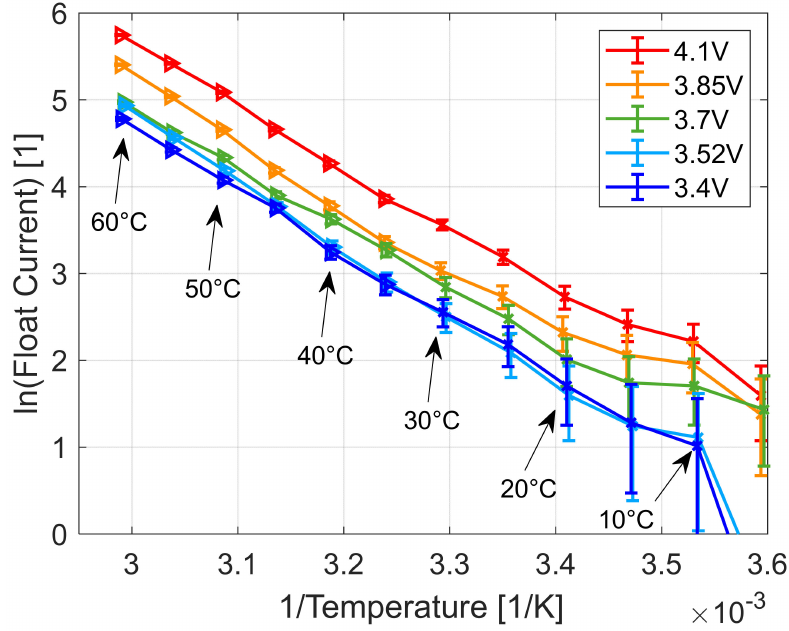
Figure 9. Arrhenius representation for all five cell potentials with the expected uncertainty by the